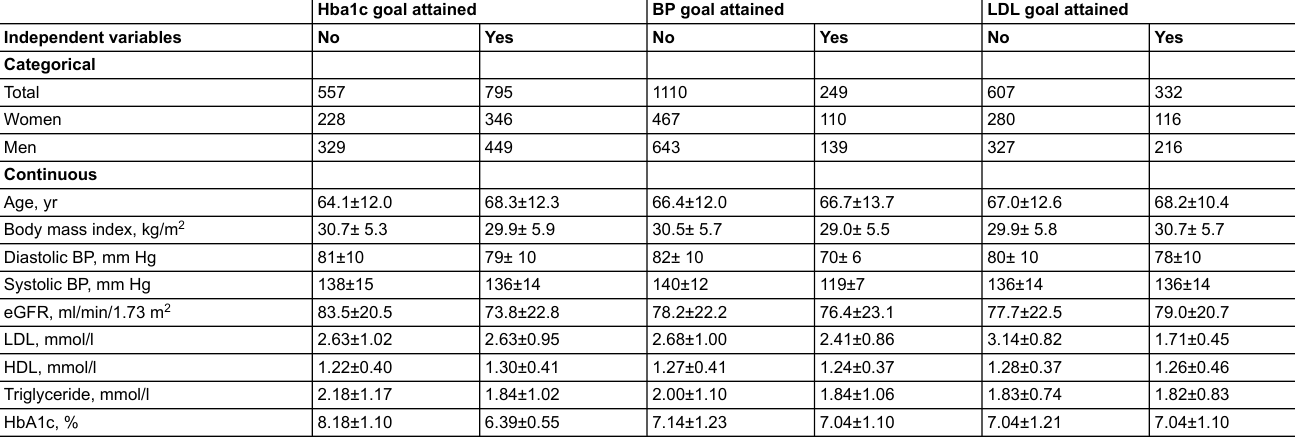
Table S1: Patient characteristics by goal